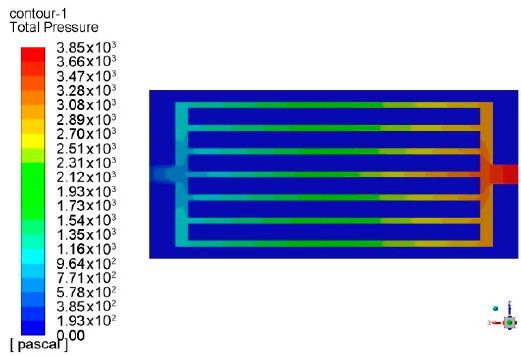
Figure 13. Pressure distribution of the cooling plate